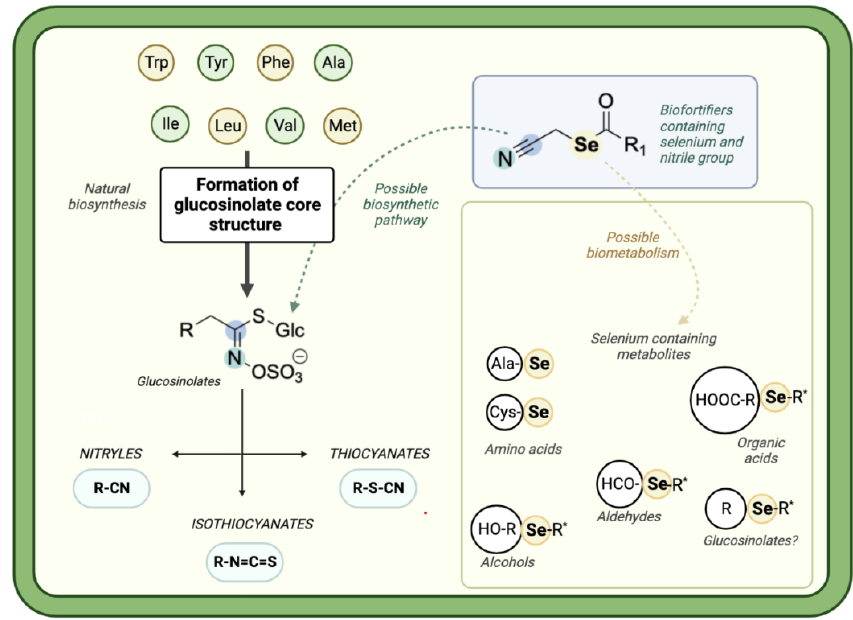
Figure 3. Possible implications of organic selenium compounds biofortification on the synthesis of active compounds in kale sprouts. * Selenosulfides, Selenoethers